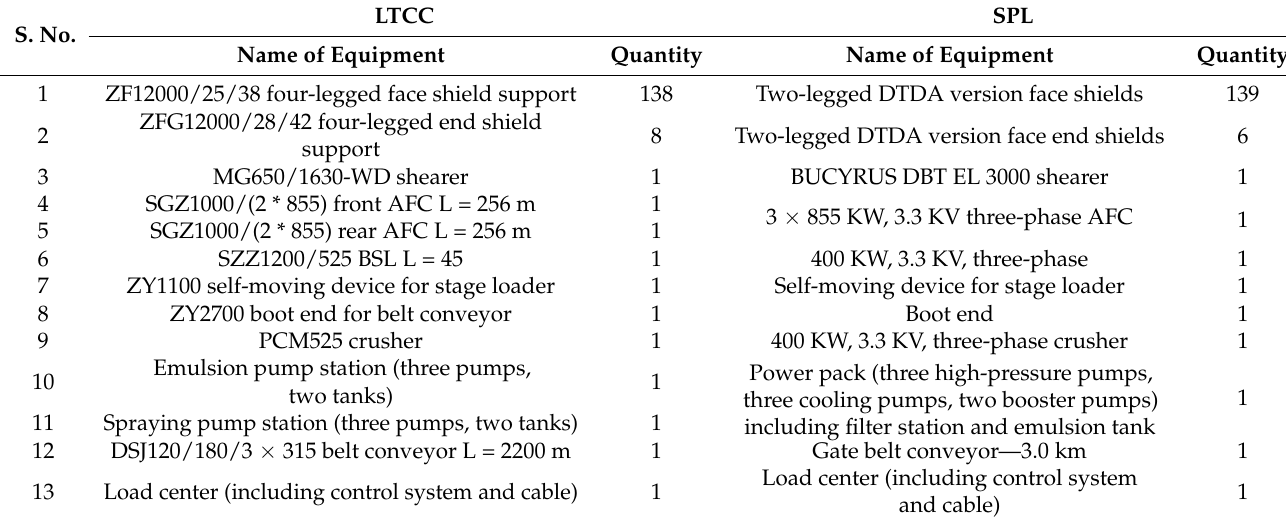
Table 8. Main top coal caving longwall equipment